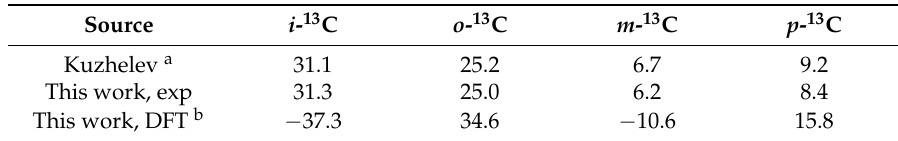
Table 3. Hyperfine coupling constants (in MHz) of the carbon atoms on the phenyl rings of trityl